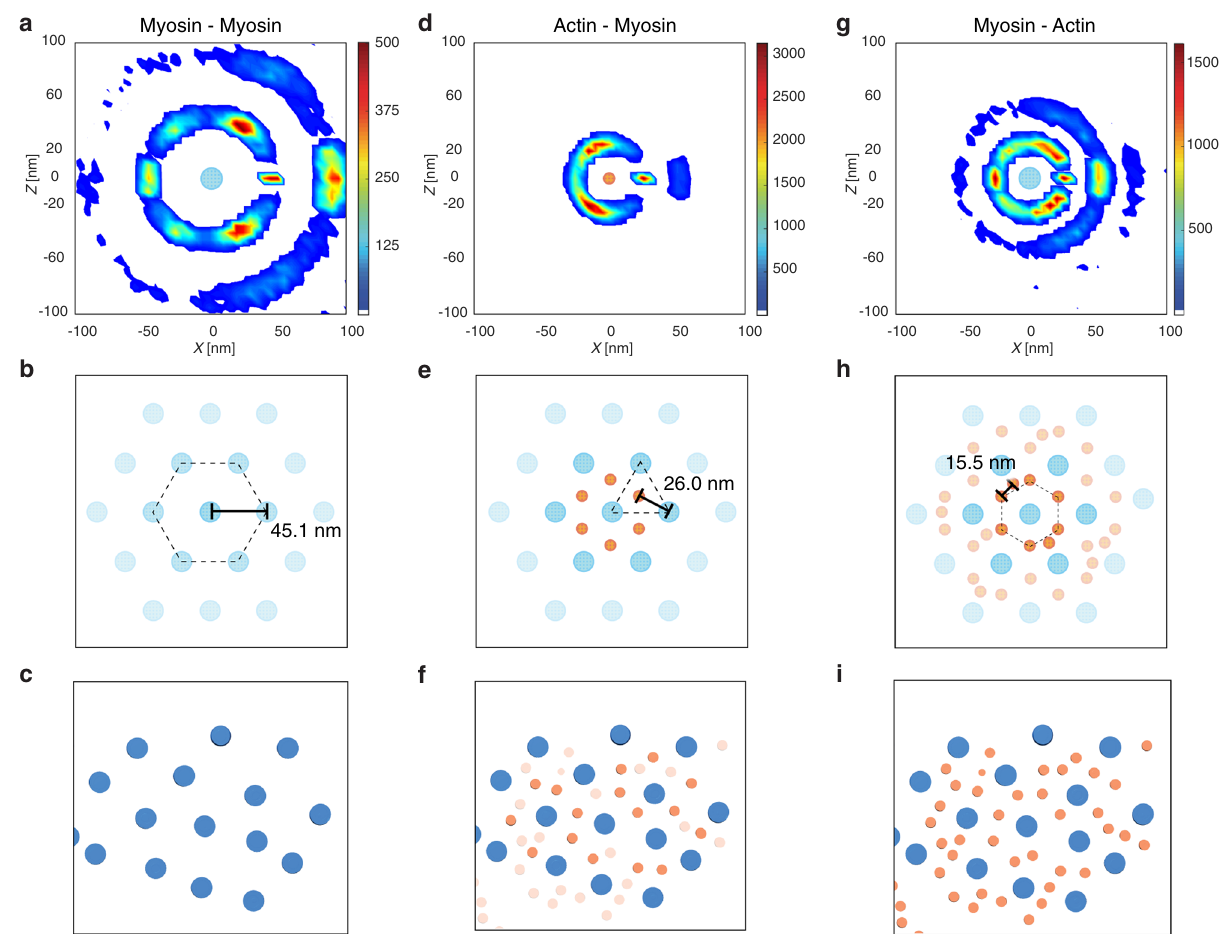
Fig. 3 Neonatal cardiac thick fi laments are hexagonally packed with an excess of thin fi laments outside the trigonal positions. a, d, g Quantitative analysis of myo fi lament packing in neonatal rat cardiomyocytes, b, e, h the schematic representation of the idealized arrays, and c, f, i the corresponding cross-sections through the single-overlap region of the myo fi bril shown in Supplementary Fig. 3e, k. See Supplementary Fig. 5 for additional cross-section examples. In short, the analysis consists of searching for parallel neighboring fi laments within the fi rst and second shells around the fi laments, using the distance ranges determined for the nearest neighbors (Supplementary Fig. 4). The plots correspond to the heat maps of neighbor positions around thick fi laments (myosin, cyan- fi lled circle; a , g ) or thin fi laments (actin, orange- fi lled circle; d ) in a plane perpendicular to the fi lament cross-sections. Since neighbors are mainly found within the fi rst shell, the second shell was blurred in b , e , h . In addition, thin fi laments outside the trigonal positions in f were also blurred to facilitate comparison with the idealized array in e . Thick fi laments assemble into a hexagonal lattice with an inter fi lament distance of about 45.1 nm ( a – c , Supplementary Fig. 4a, b). Thin fi laments are found at about 26.0 nm from three neighboring thick fi laments ( d – f , Supplementary Fig. 4c – f). They are also located outside the trigonal positions of the thick fi lament lattice ( g – i ), as indicated by the more even distribution of density in the fi rst shell in g and the distance of about 15.5 nm between nearest parallel thin fi laments (Supplementary Fig. 4g,